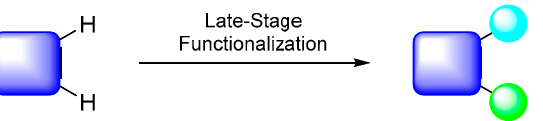
Figure 2. LSF operates C–H functionalization chemistries to directly modify lead structures, providing new analogs without resorting to de novo synthesis.